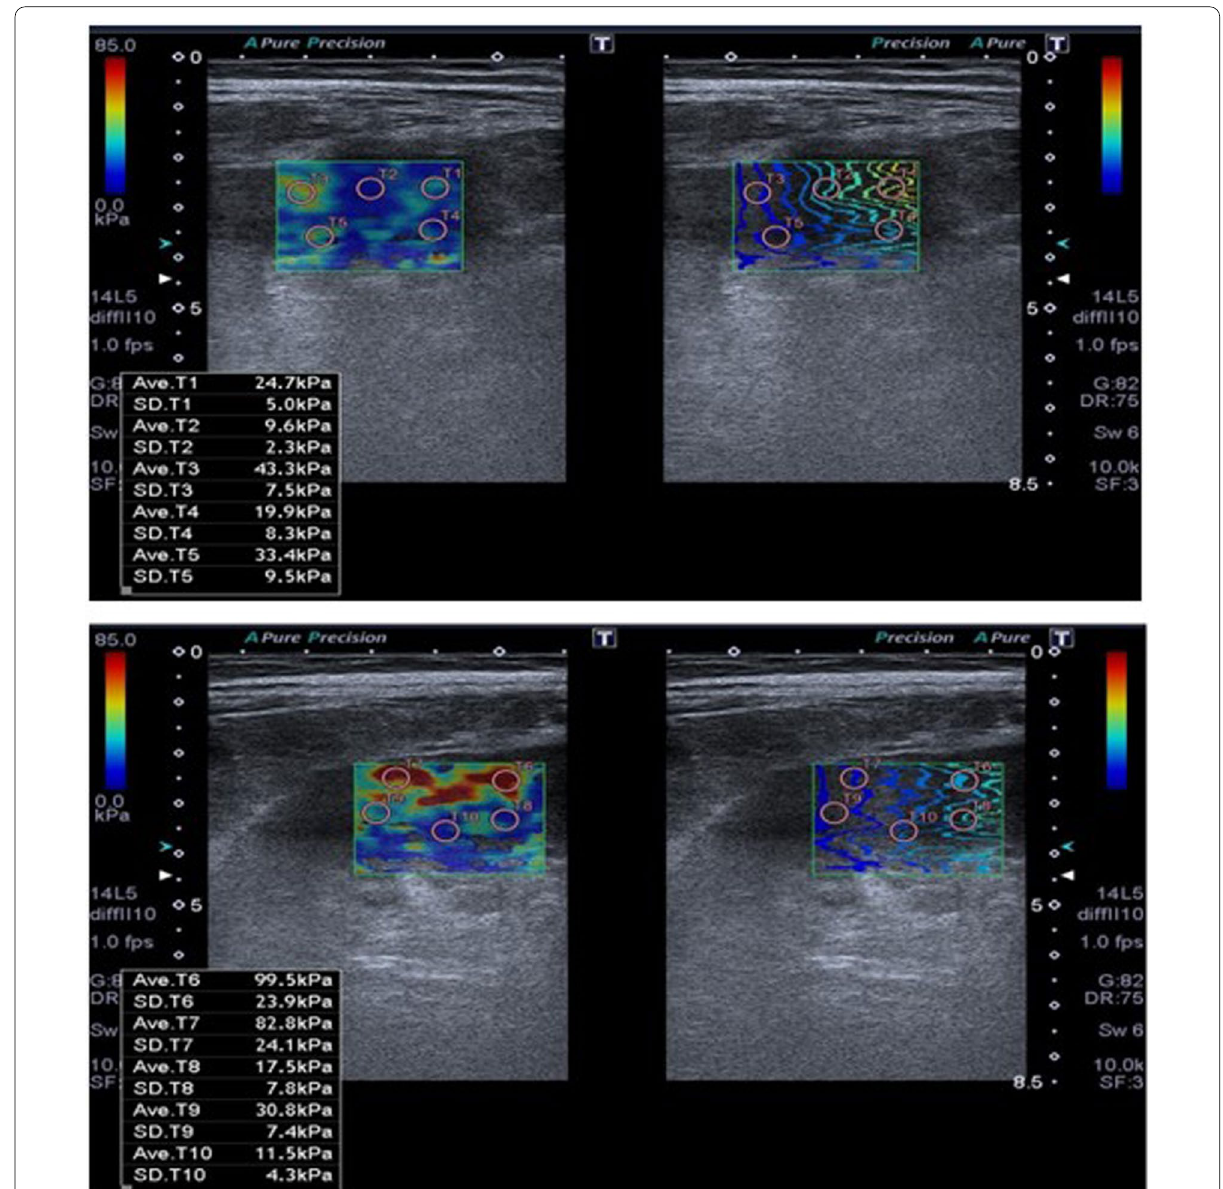
Fig. 1 Shear wave elastography stiffness values in kPa in case of chronic allograft nephropathy. Legend : Mean stiffness value of the transplanted kidney 37.3 kPa. Pathology revealed moderate interstitial fibrosis and tubular atrophy (IFTA grade II,